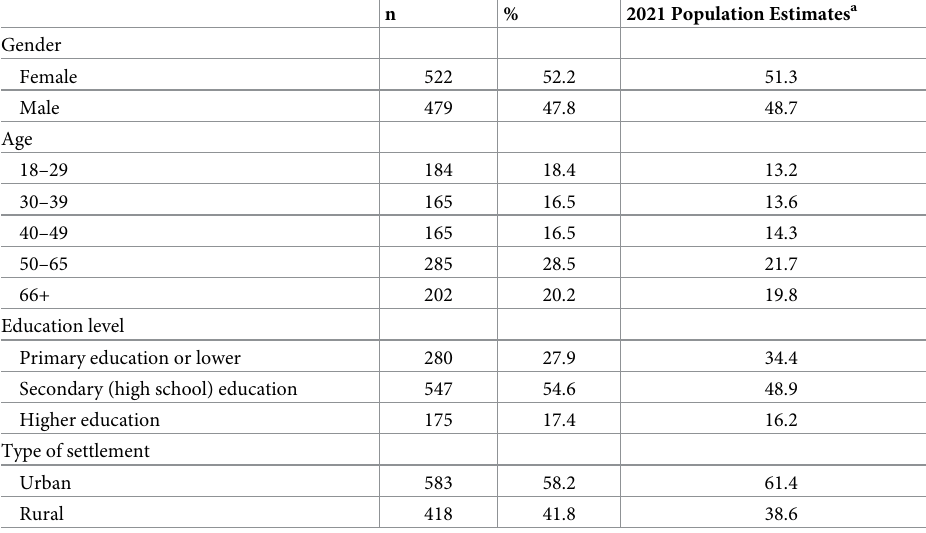
Table 1. Socio-demographic breakdown of the sample—Study 1.